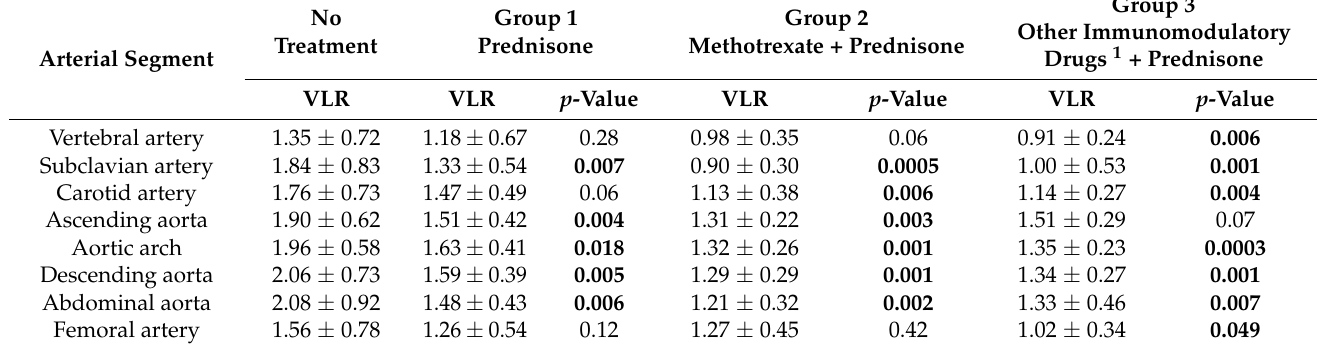
Table 3. The vessel wall-to-liver ratio (VLR, mean ± SD) for subjects without treatment and different groups receiving either prednisone alone (Group 1), methotrexate in combination with prednisone (Group 2) or other immunomodulatory drugs in combination with prednisone at the time of PET/CT (Group 3). The p-values were derived from comparison of different groups vs. treatment-naïve patients at time of scan. The number of significant vessel segments increased with the additional intake of immunomodulatory drugs.